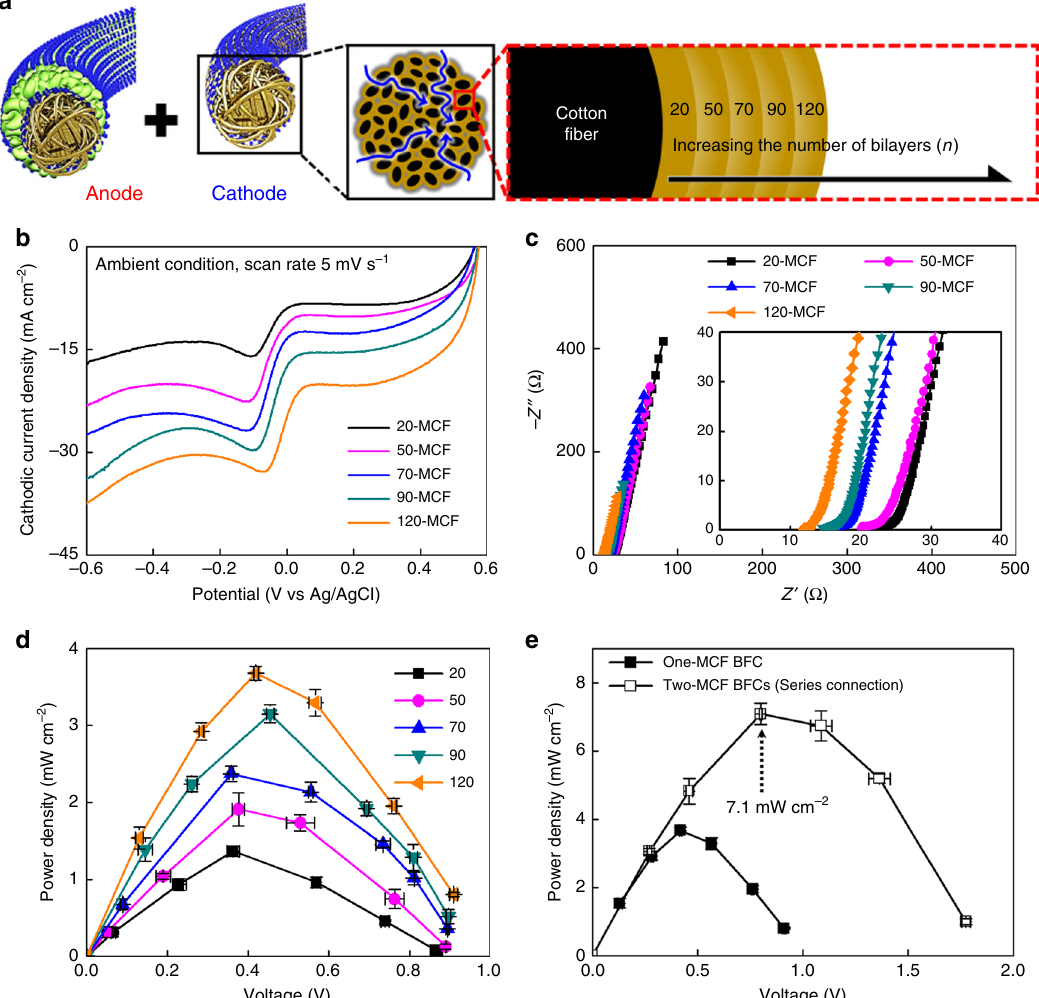
Fig. 5 Enhancement of the power output of a metallic cotton fi ber-based biofuel cell. a Complete metallic cotton fi ber-based biofuel cells (MCF-BFCs) with a constant anode (30-bilayered glucose oxidase (GOx)/tris-(2-aminoethyl)amine (TREN)) multilayer-coated MCF (i.e. 30-GOx/20-MCF) and cathodes with a controlled number of bilayers n ( n -bilayered metallic cotton fi ber, n -MCF). b Cathodic current curves for n -MCF cathodes as a function of n . c Nyquist plots of the MCF cathodes depending on n . In this case, the equivalent series resistance (ESR) values for n = 20, 50, 70, 90, and 120 were approximately 24, 22, 17, 16, and 13 Ω , respectively. d Power output of the MCF-BFCs (an n -MCF cathode and a 30-bilayered GOx/TREN multilayer-coated 20-bilayered MCF anode) with external resistors (1 k Ω ~10 M Ω ) as a function of n -MCF. e Power outputs of one and two MCF-BFCs composed of the 120- MCF cathode and the 30-GOx/20-MCF anode. In these cases, the two MCF-BFCs were connected with each other in series, and its power output was also measured with current output through operating a cell potential by an external resistor. The error bars ( d , e ) show the standard deviation from the mean value of power densities for 3 − 5 independent